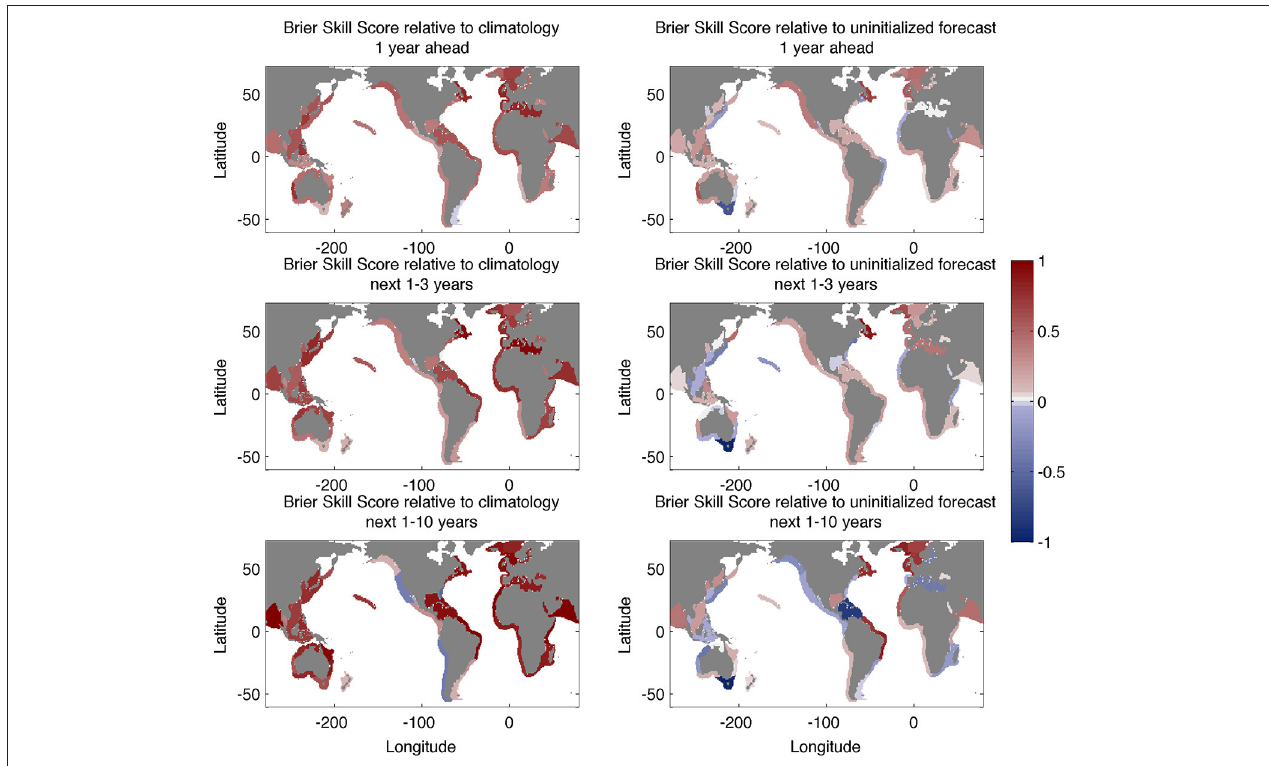
FIGURE 7 | Brier Skill Score (BSS) for lower SST tercile predictions relative to climatology (left) and uninitialized predictions (right) for a 1 year ahead forecast and over the next 3 and 10 years. The BSS ranges from 1 (perfect score) to negative infinity (no skill). Negative scores indicate no additional skill as compared to the reference